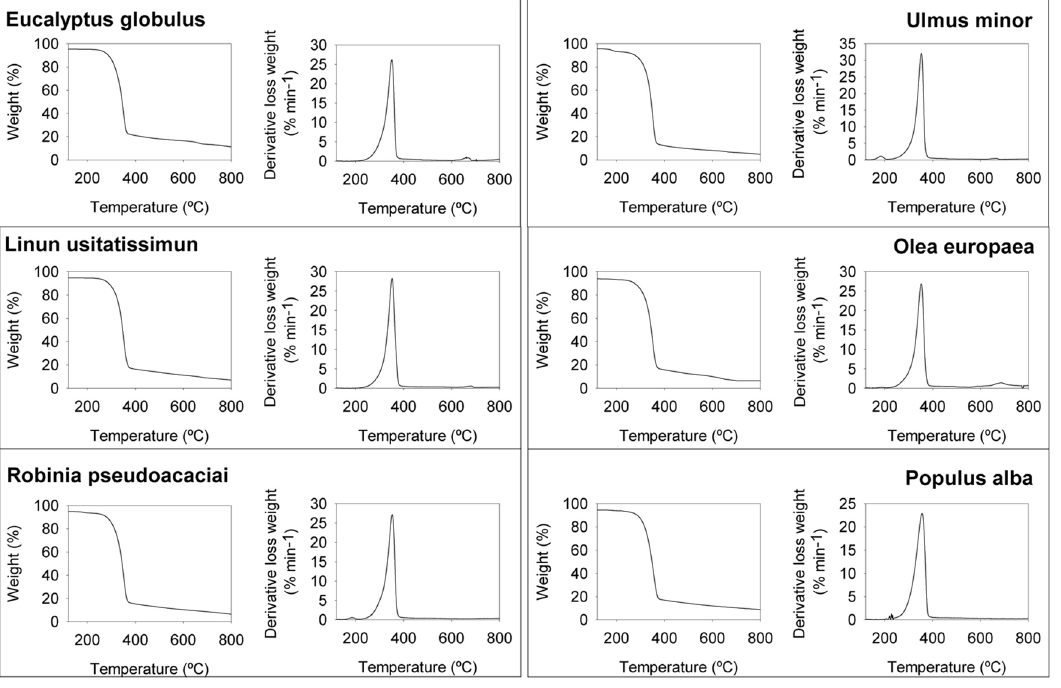
Figure 1. TGA and DTG at 15 °C min − 1 of the studied cellulose samples.